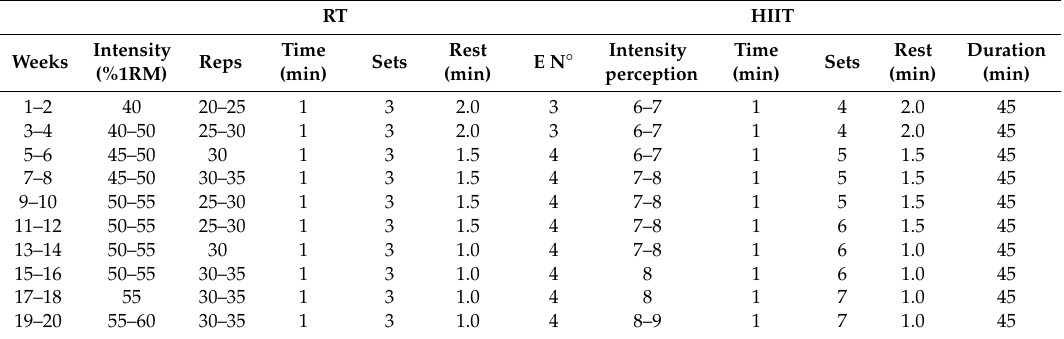
Table 1. Characteristics of the concurrent training programme (2 times /